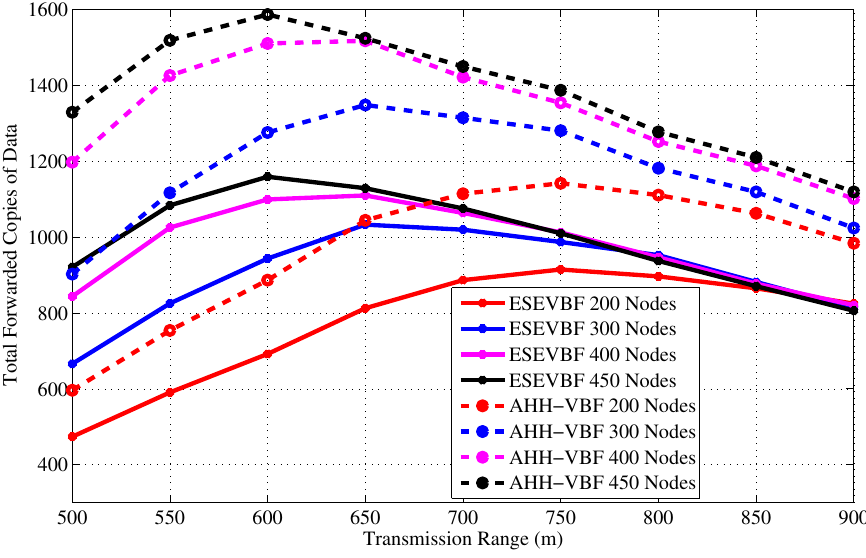
Figure 6. Number of data message copies forwarded in the network for different transmission